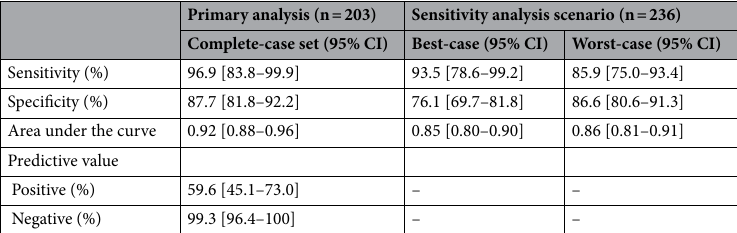
Table 2. Diagnostic accuracy for referable diabetic retinopathy. CI, confidence